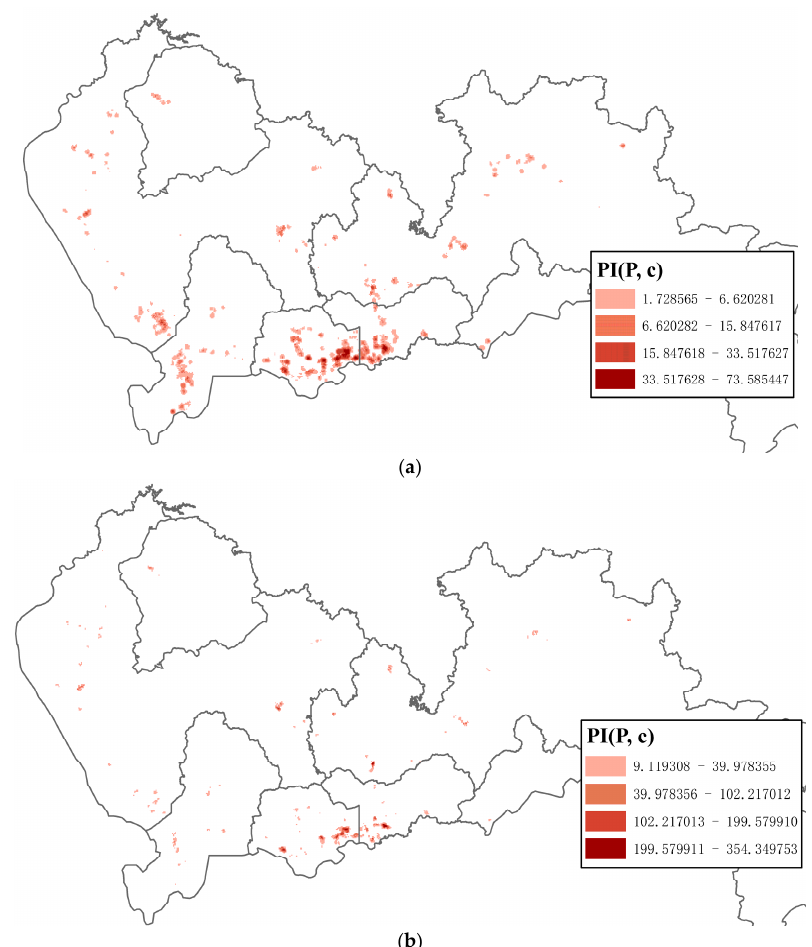
Figure 7. The prevalence surfaces created by combining multiple kernel density estimation surfaces with respect to the: ( a ) size-2 pattern {bank, retail store}; and ( b ) size-3 pattern {bank, retail store,